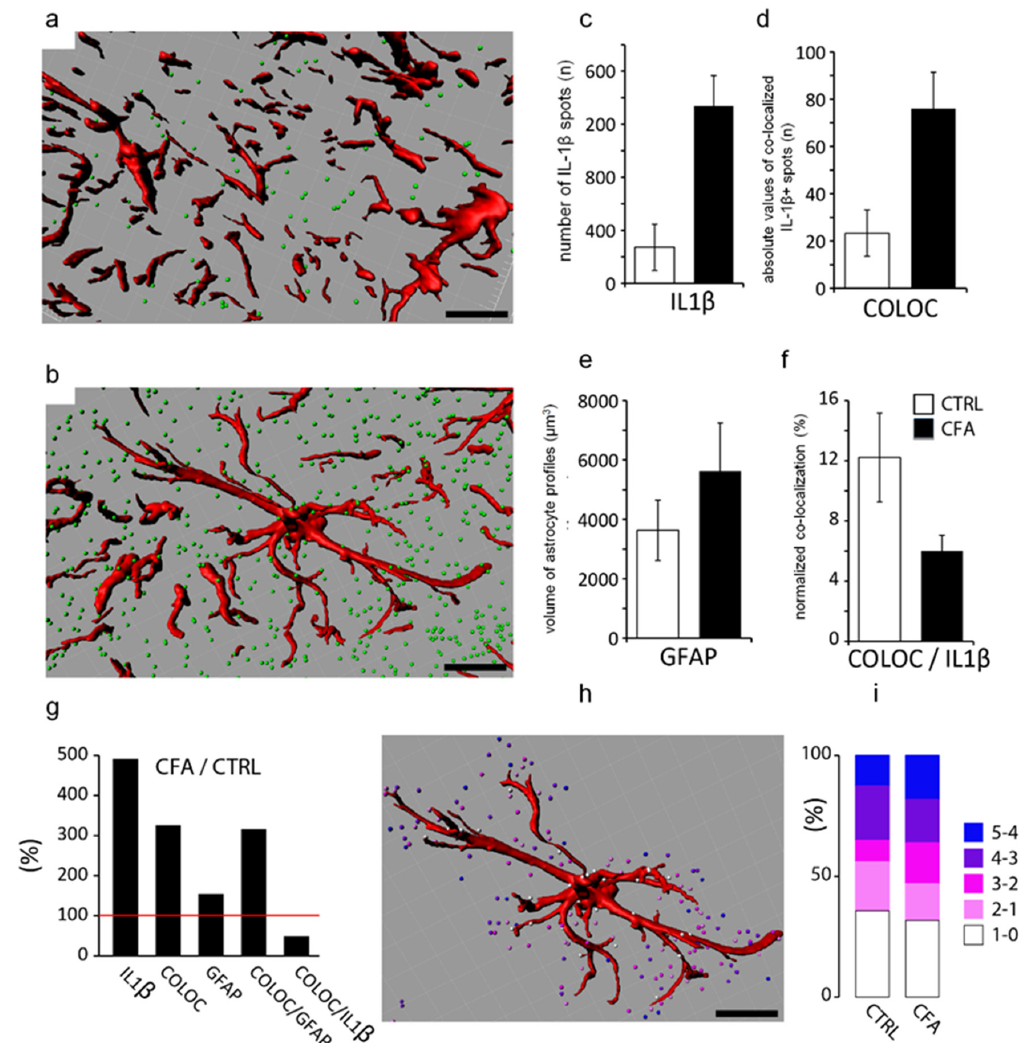
Figure 4. Quantitative analysis of spinal IL-1 β expression and co-localization with glial markers. The co-localization with astrocytes and the morphological differences between astrocytes taken from control ( a ) or CFA-treated samples ( b ) were also quantified by IMARIS software analysis ( a , b ,h, i ). Scale bars: 5 μ m. ( c ) Software calculation showed significantly enhanced number ( n ) of IL-1 β spots ( p = 0.009032) in chronic pain (gray column) compared to control (white column). ( d ) Absolute values ( n ) of co-localized IL-1 β spots (COLOC) on astrocytes were also found to be significantly higher ( p = 0.022896) in CFA model (gray column). ( e ) IMARIS evaluation of volume change ( μ m 3 ) in astrocyte profiles demonstrated considerable increase (gray column) ( p = 0.194406) after CFA injection in comparison with control (white column). ( f ) Histogram showing the percentage ratio of normalized co-localization to the total number of IL-1 β spots (COLOC/IL-1), indicating a significantly higher ( p = 0.0366) co-localization in control (white column) than in CFA-treated animals (gray column). ( g ) Overall histogram shows the percentage ratio of CFA to CTRL related to IL-1 β number (IL-1 β ), its absolute and relative co-localization with astrocytes (COLOC, COLOC/IL-1), and GFAP volumes. Data are shown as mean ± SEM. ( h , i ) Distance measurement (0–5 μ m) of IL-1 β spots from the astrocyte profiles by IMARIS program. No significant differences were observed between the control and CFA groups; the majority of IL-1 β spots (%) were found within 1 μ m distance from glial cells in both groups.